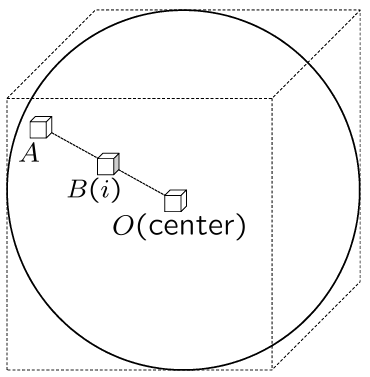
Figure 2. Radial suppression of voxel intensities.